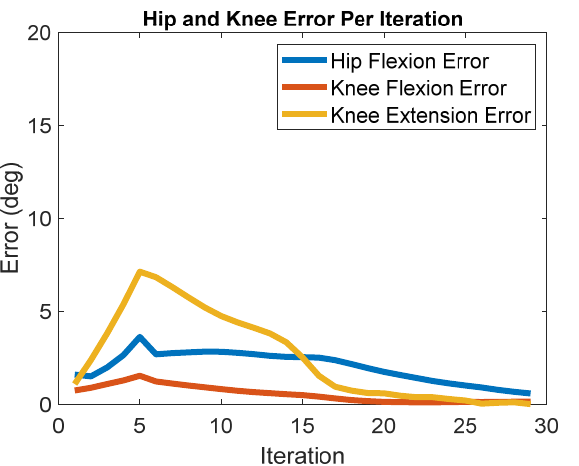
Figure 5. Absolute terminal error over each iteration in the presence of simulated fatigue.